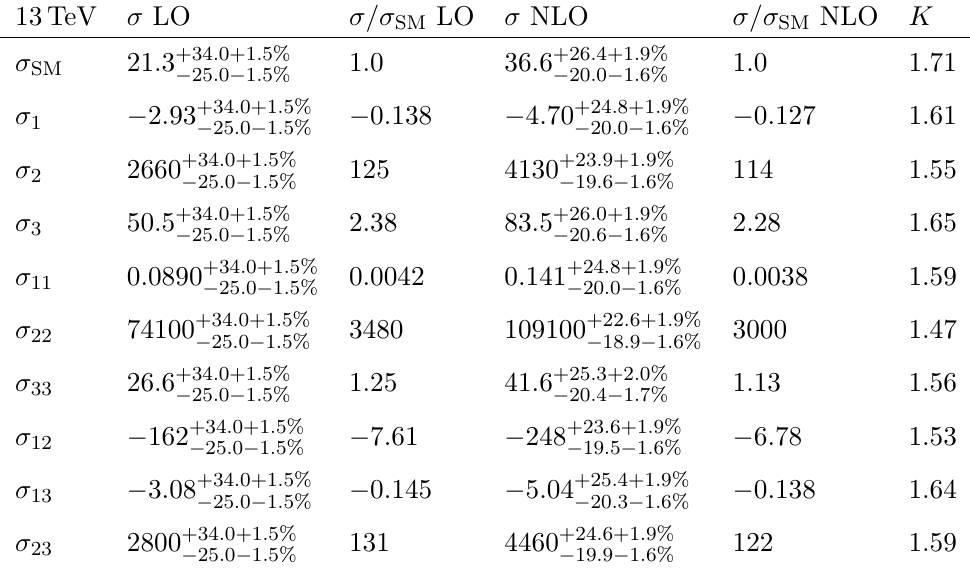
H at 13 TeV, as parametrised in eq. !